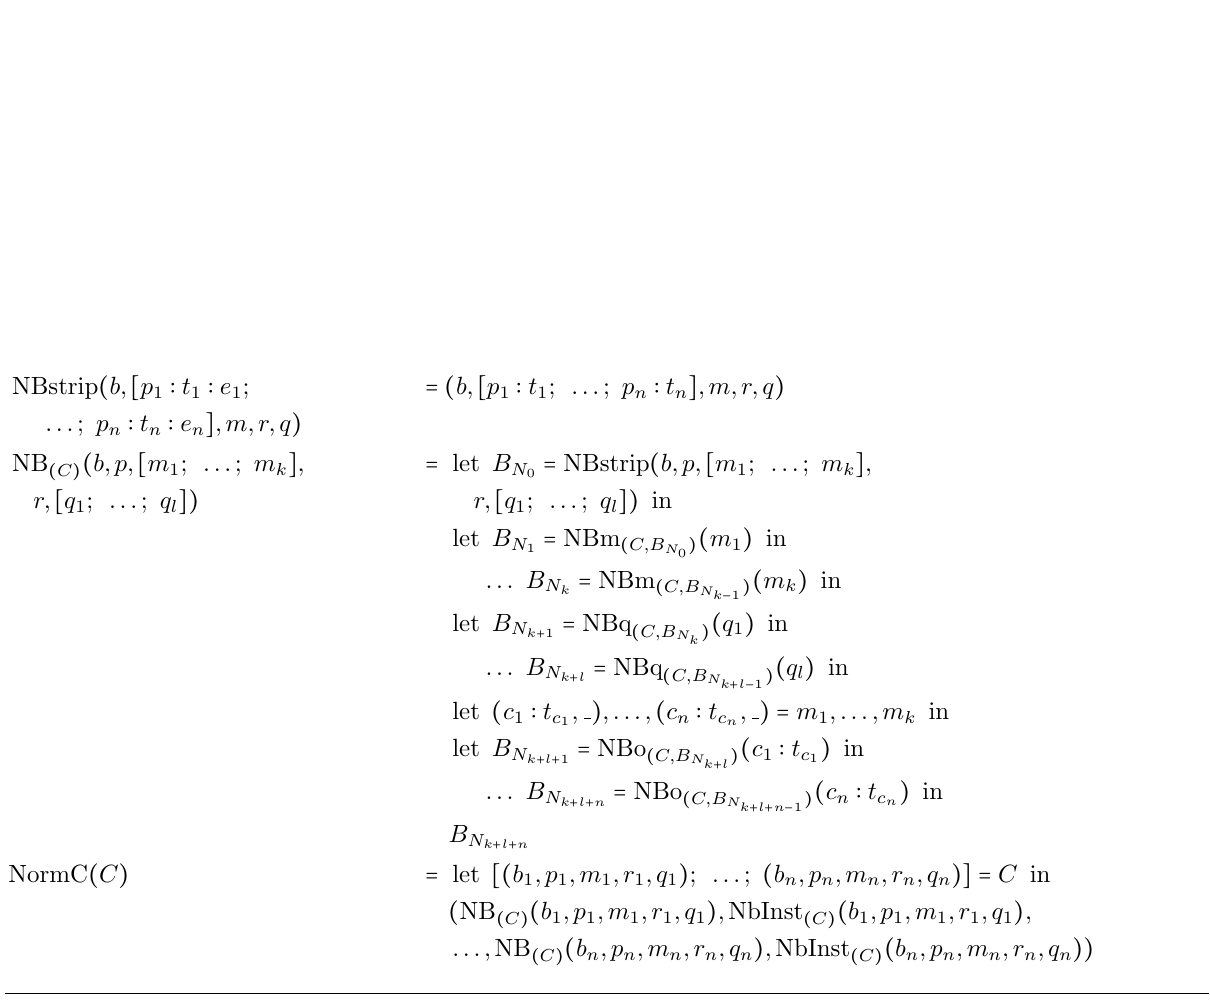
Figure 19: Function NormC—Normalization transformation on the auxiliary structure C . Applies NB and NbInst (see Section B.3) to each block. Function NB uses NBstrip to remove parameter modifications, NBm (defined in Figure 20) to normalize component modifications, NBq (defined in Figure 21) to extract and normalize dot accesses appearing in RHS expressions and NBo (defined in Figure 22) to add “dummy” equations for component outputs that are not